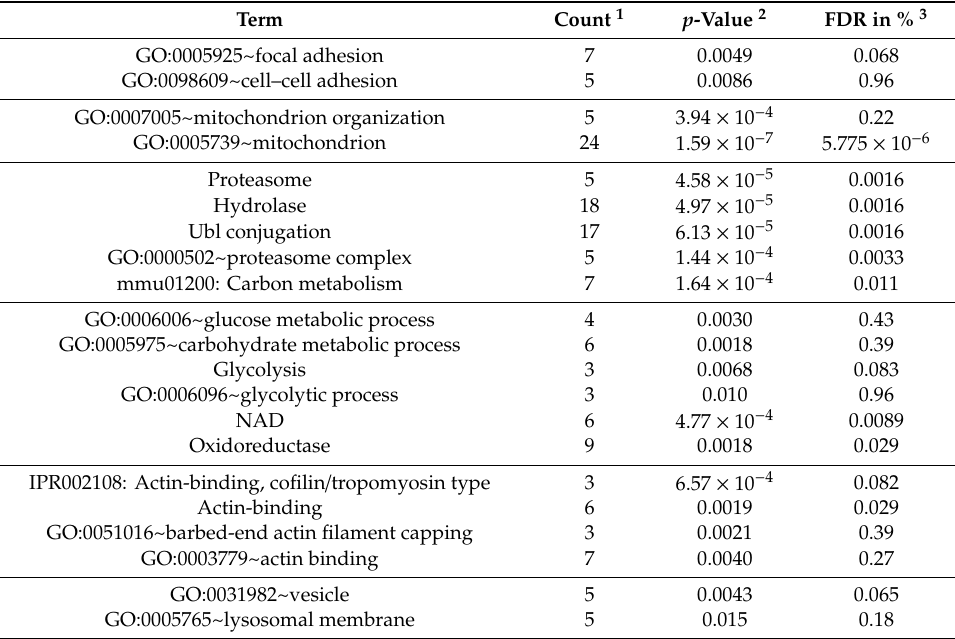
Table 2. Selection of modulated pathways highlighted by the DAVID functional annotation chart tool.